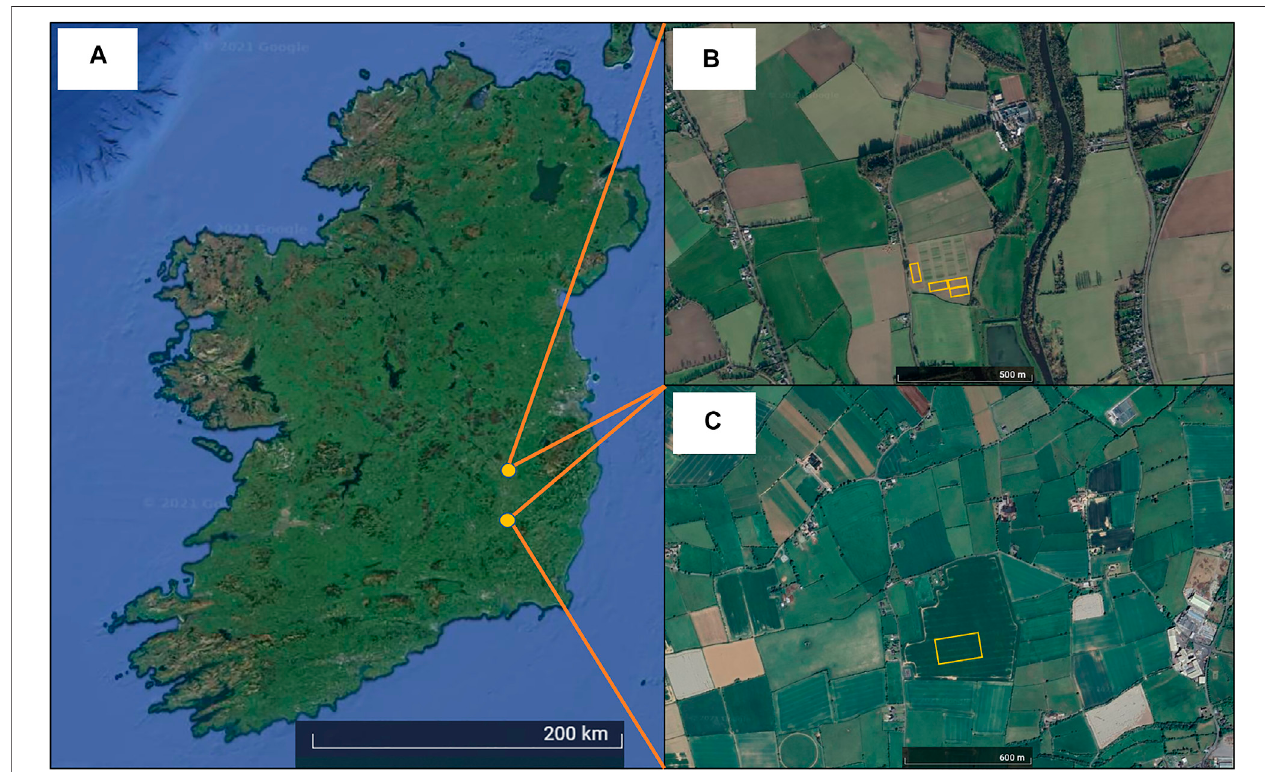
FIGURE 1 | Geographical overview of Ireland (A) and the locations of the study sites in (B) Knockbeg, Co. Laois and (C) Goresbridge, Co. Kilkenny, with the surrounding agricultural land uses (Google Earth; created on 31st July 2021). Orange lines indicate the location of the experimental trial plots.